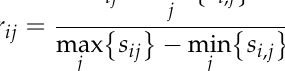
Table 6. Normalized score matrix.